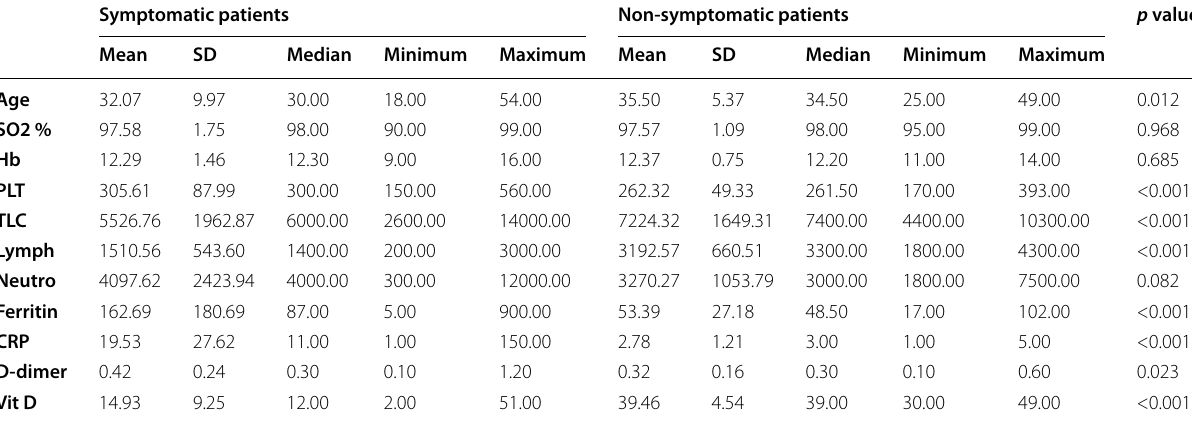
Table 1 Age and investigations of the patients Symptomatic patients Non-symptomatic